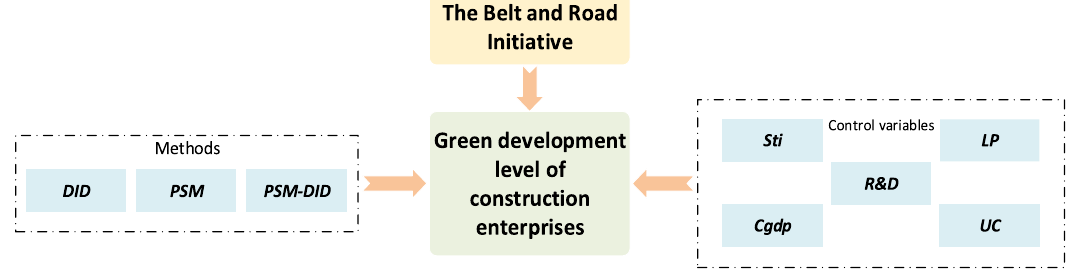
Fig. 1 Technology roadmap of the ‘ B&R Initiative ’ policy to the GD level of construction enterprises. Three methods are used to explore the impact of the B&R policy on the green development of construction enterprises with fi ve control variables. Sti sewage treatment investment, R&D research and development investment, LP labour productivity, Cgdp per capita GDP, UC undergraduate students in colleges and universities, DID differences-in- differences, PSM propensity score matching.